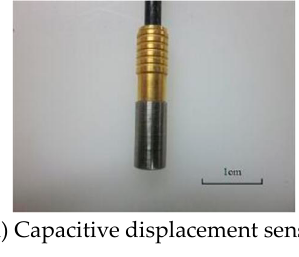
Figure 10. Sensors.